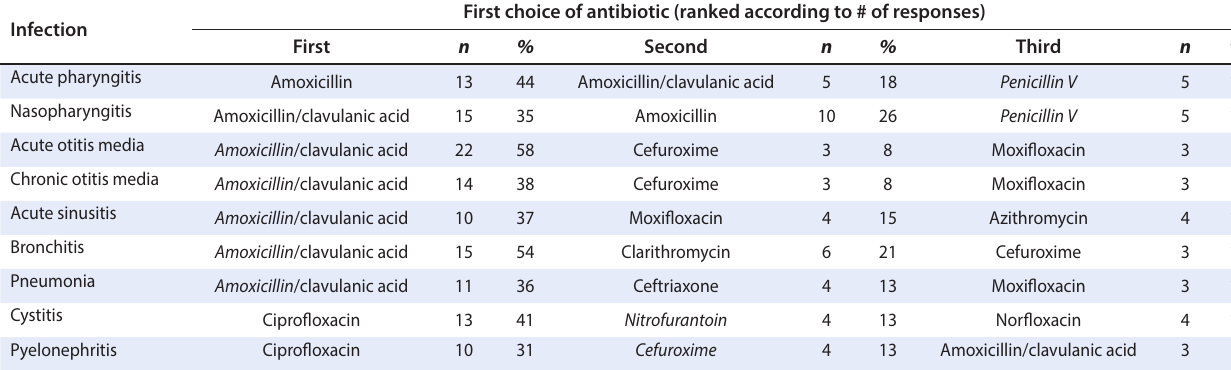
Table 2: Preferred first choice of antibiotic for different common infections with first-line antibiotics recommended in the national STGs in italics